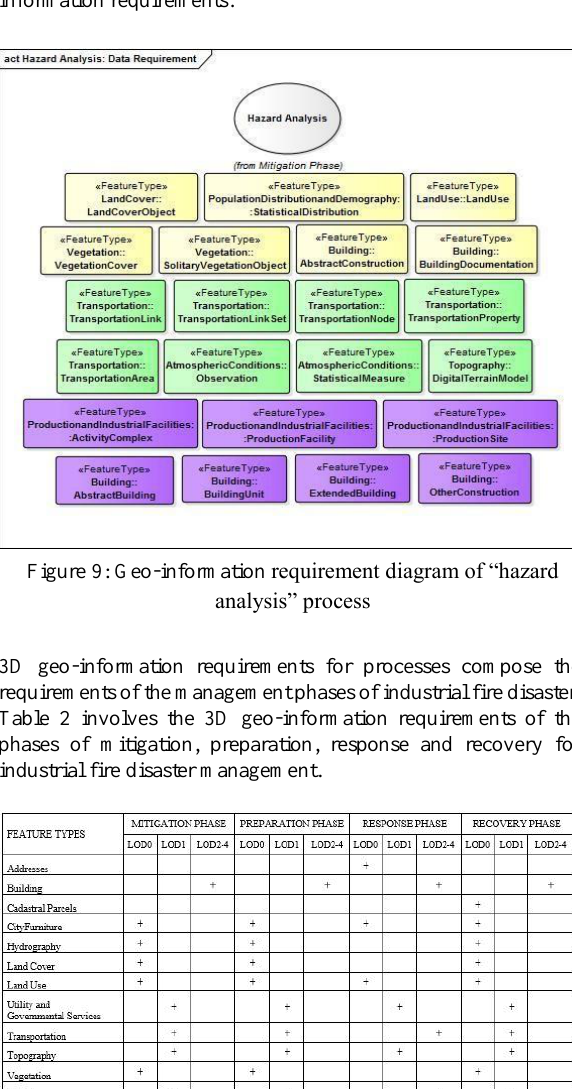
Figure 8. The yellow classes are created for presenting the LODO geo-information requirements. The green classes are used to show the LOD1 geo-information requirements. The classes in purple are defined for showing LOD2, LOD3 and LOD4 geo- information requirements.